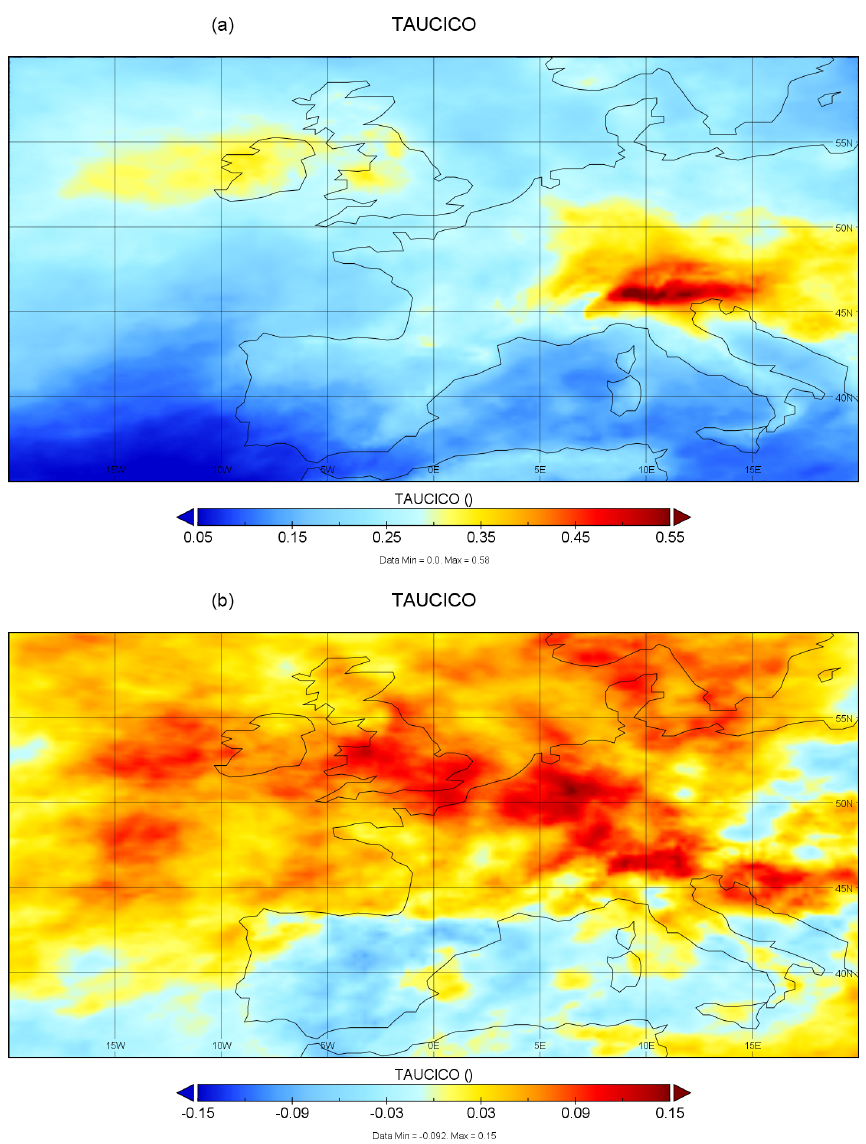
Figure 10. Mean cirrus optical thickness (OT) (nondimensional) in the sum of IFS and CoCiP results from March–August in 2019 (a) and the 2019–2020 difference (b)